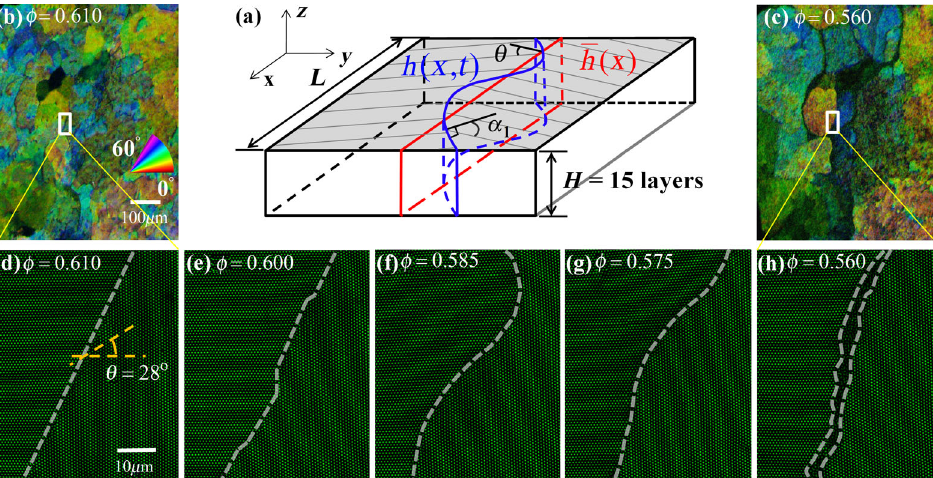
FIG. 1. Evolution of the grain-boundary morphology. (a) Schematic illustration of a grain boundary in a thin-film colloidal crystal with lateral length L , mismatch angle θ , and an inclination angle α 1 . The shape of the grain boundary h ð x; t Þ (blue curve) is defined as the ¯ h ð x Þ (red line). The parallel grey lines in the shaded area represent the displacement relative to the average position of the grain boundary ¯110 ½ (cid:2) direction of the lattices. (b,c) Raw images of the colloidal polycrystal under the Bragg-diffraction microscopy at (b) ϕ ¼ 0 . 610 and ¯110 (c) ϕ ¼ 0 . 560 . The true colors represent the local ½ (cid:2) lattice orientation β ∈ ½ 0 ° ; 60 ° (cid:2) shown in (b). Grains with β ¼ 0 ° and disordered grain boundaries are shown in black. (d) – (h) The grain boundary with θ ¼ 28 ° in the small rectangular area in panels (b) and (c) is straight in panel (d), develops steps in panel (e), and is curved and completely rough without line segments in panel (f). Its fluctuation amplitude decreases in panel (g), and finally, it melts in panel